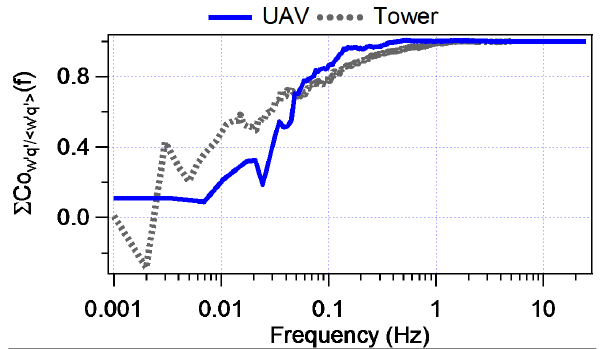
Fig. 5. Integrated Co <w 0 q 0 > plots (ogives) from unfiltered data normalized to total covariance ( < w 0 q 0 > ) for 520m UAV run at 10:40a.m. and tower data at 10:17a.m. Indicating T m of 289 (1/0.00346Hz) and 1000s is suitable for UAV tower flux calcula- tions, respectively. Tower measurements have a greater influence of the higher frequency turbulent data, and take longer to reach an asymptote at the low frequency region; the narrower flux bandwidth for the UAVs is due to aircraft movement through the turbulent